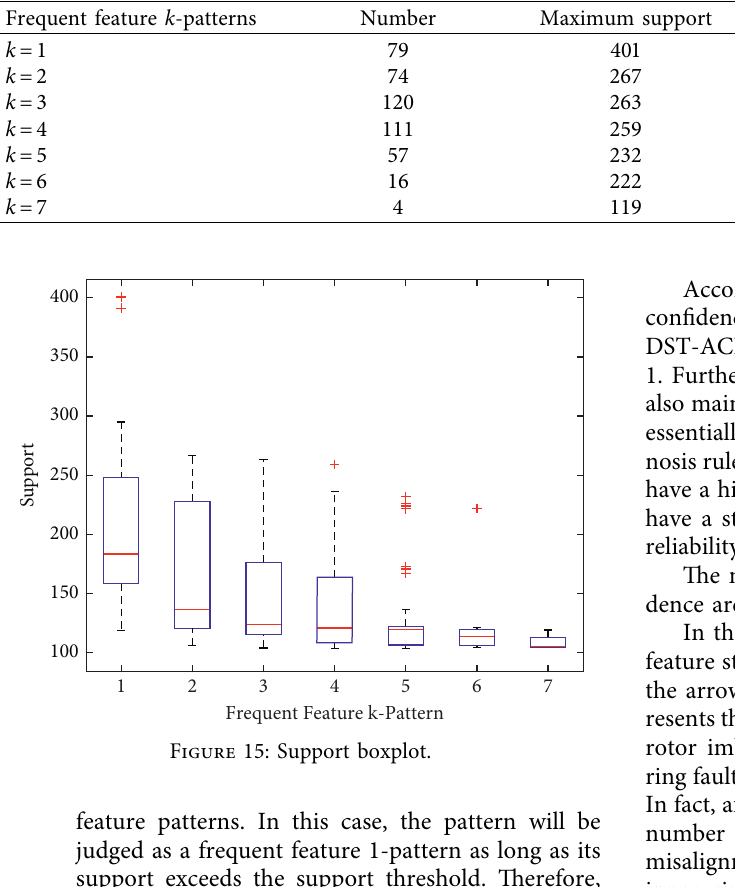
Table 2: Results of frequent feature pattern mining.